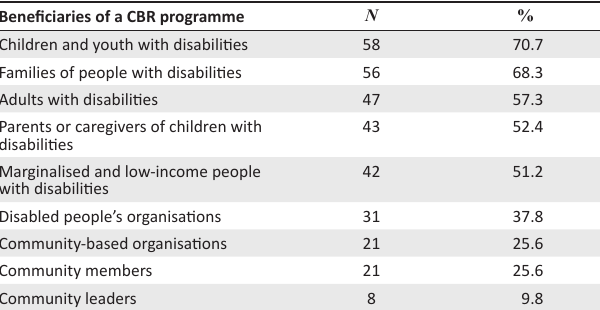
TABLE 4: Beneficiaries of community-based rehabilitation programmes ( N = 82) (multiple responses allowed).